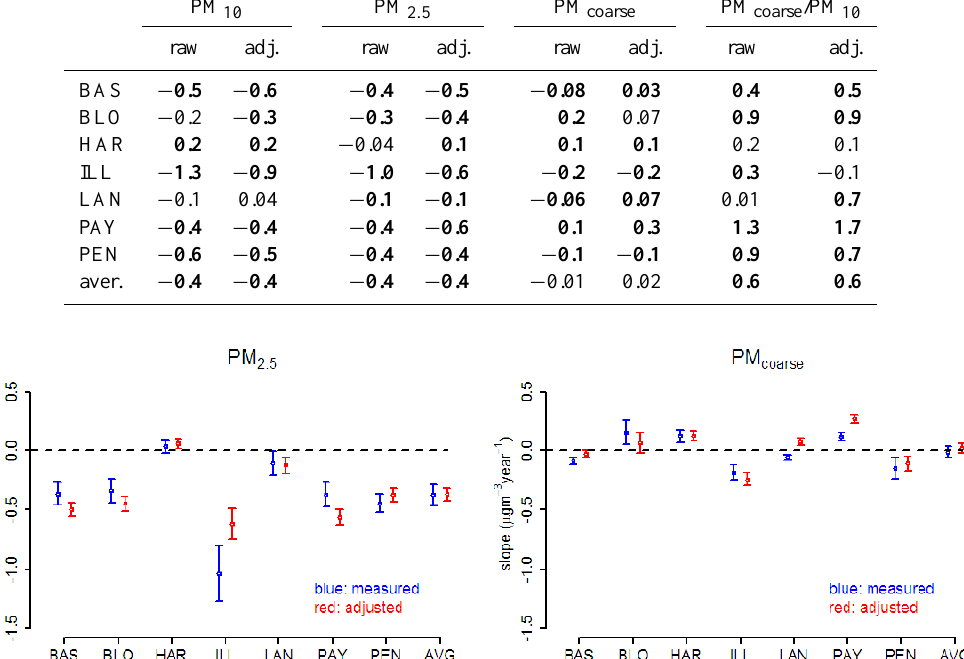
Fig. 5. Linear regression slopes and 95% confidence intervals of the raw and meteorologically adjusted PM 2 . 5 time series (left) and for PM coarse (right) for all sites. The average over all sites is shown last along with error bars calculated by error